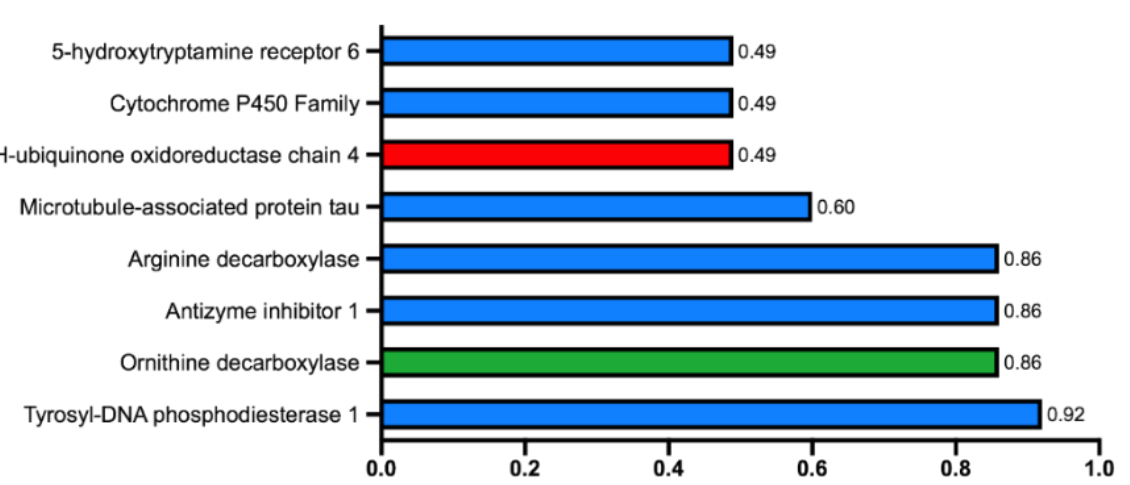
Figure 1. SwissTargetPrediction results for deguelin binding to human proteins. Results are shown in percentage and with cytochrome P450 family the results were grouped. In green are shown the possible therapeutic targets, in red are shown those targets with toxic effects described in the literature, and in blue are shown targets that do not show any adverse pharmacological effect in the literature.